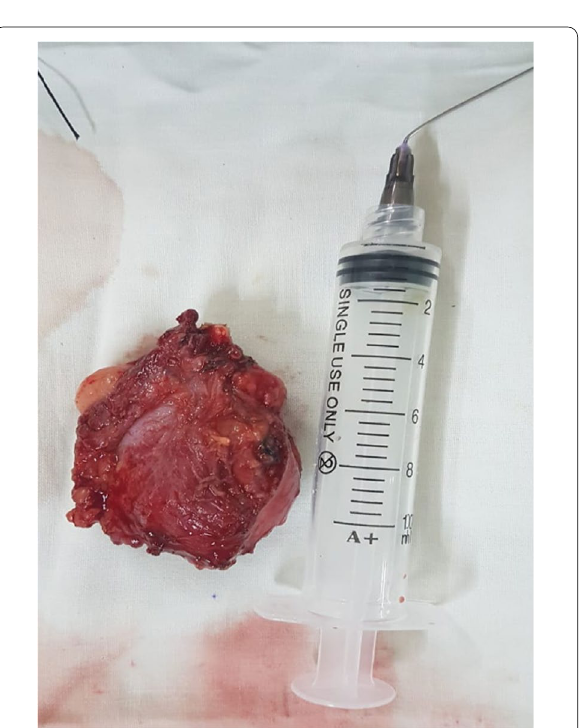
Fig. 3 Marking of a transverse incision